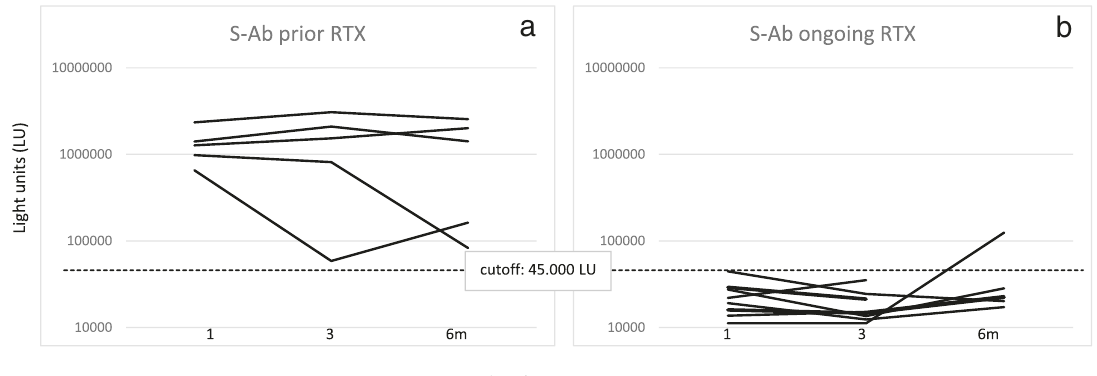
Fig. 5 Longitudinal pro fi le of antibodies against the spike protein in hematological patients receiving prior or ongoing rituximab treatment. Spike antibody (S-Ab) levels were determined at 1, 3, and 6 months after nasal swabs became PCR-negative in hematological patients receiving prior ( a ) or ongoing rituximab treatment ( b ). The cutoff value for determining seropositivity for S-Ab is shown by the dotted